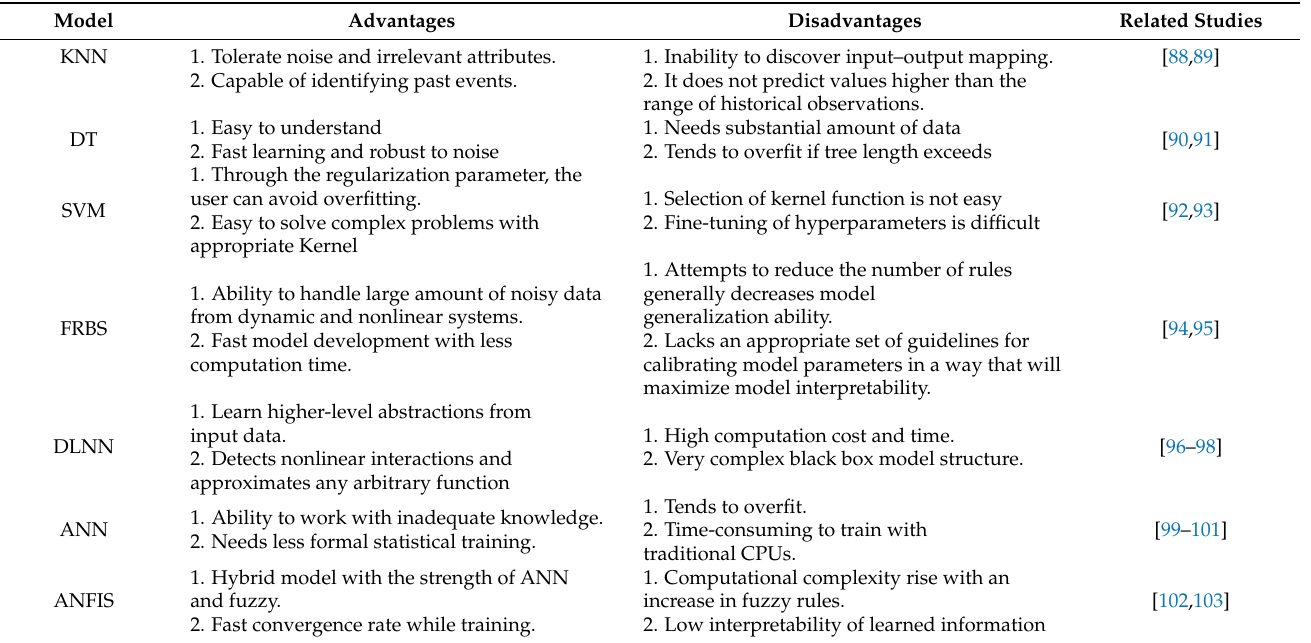
Table 2. Advantages and limitations of ML models.